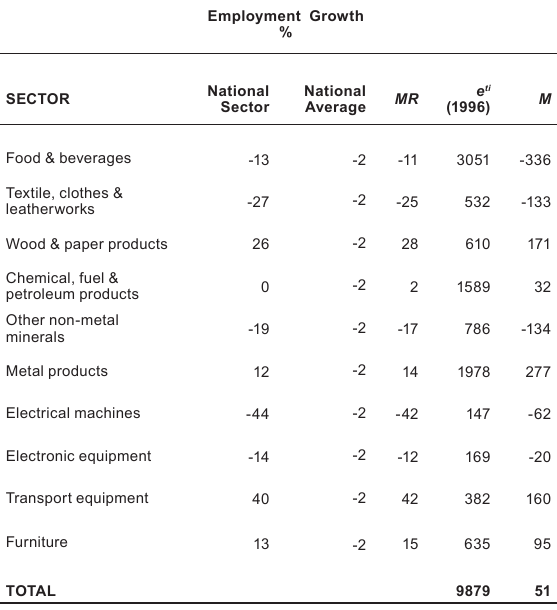
Table 4 Industry mix effect (m) in the Southern District